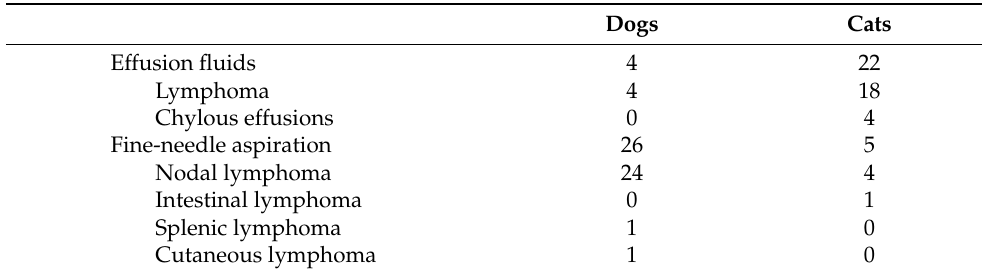
Table 1. Type of specimen and cytology diagnosis of enrolled canine and feline